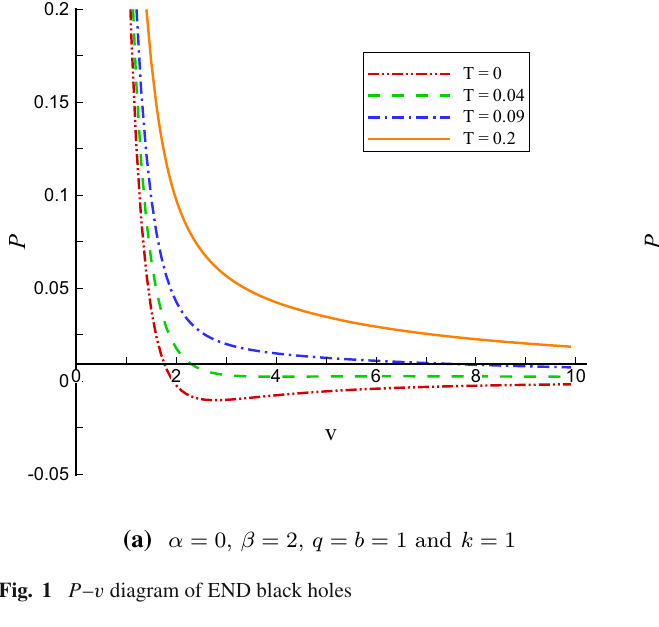
Fig. 1 P – v diagram of END black